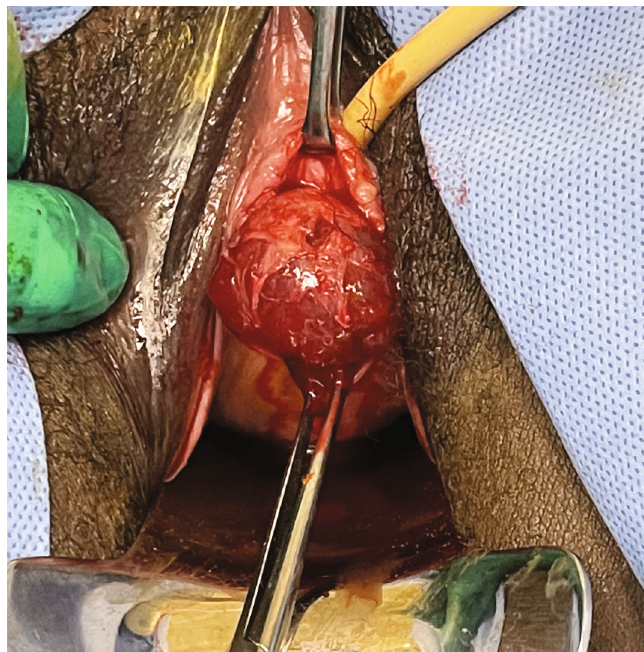
Figure 1: Gelatinous cystic mass protruding from the anterior vaginal